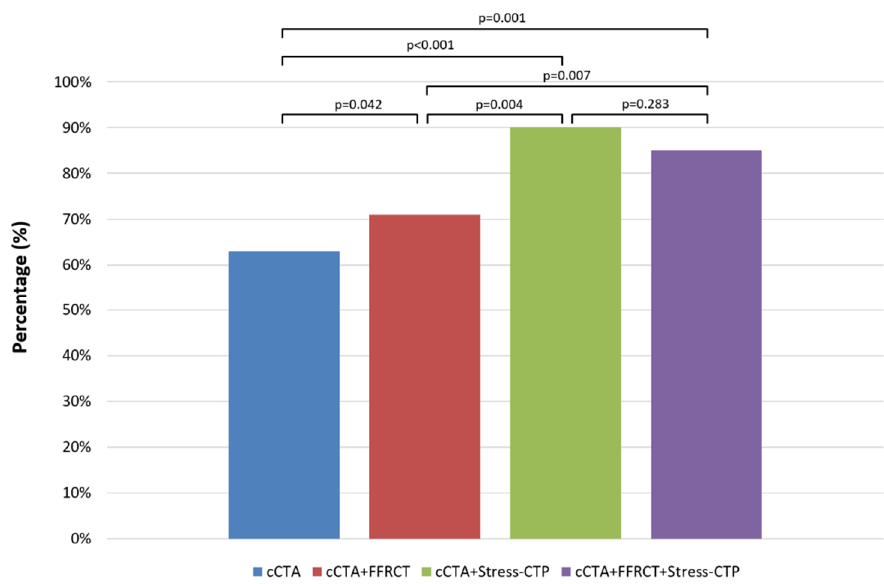
Figure 6. Primary endpoint of the study between di ff erent diagnostic strategies. Both the cCTA + Stress-CTP and cCTA + FFR CT + Stress-CTP strategies showed a higher rate of agreement with the final decision as compared to cCTA alone and the cCTA + FFR CT strategy. cCTA: coronary computed tomography angiography; Stress-CTP: stress computed tomography perfusion; FFR CT : computed tomography-derived fractional flow reserve.